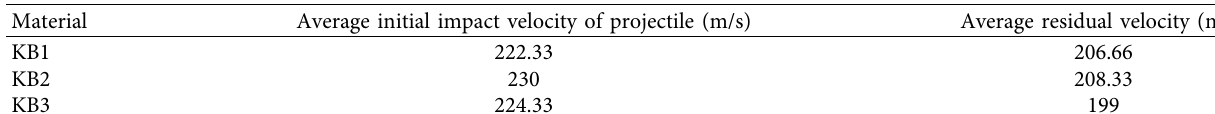
Figure 6: Schematic setup of bullet impact test. Table 3: Velocities of the projectile.